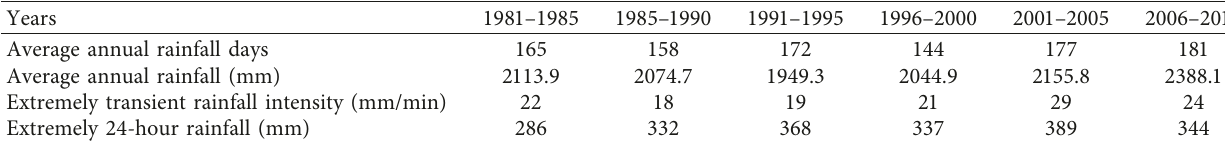
Figure 4: Some typical sensors: (a) the FBG displacement sensor; (b) the pore pressure sensor. Table 3: Rainfall data in Guizhou Province during recent 30 years.